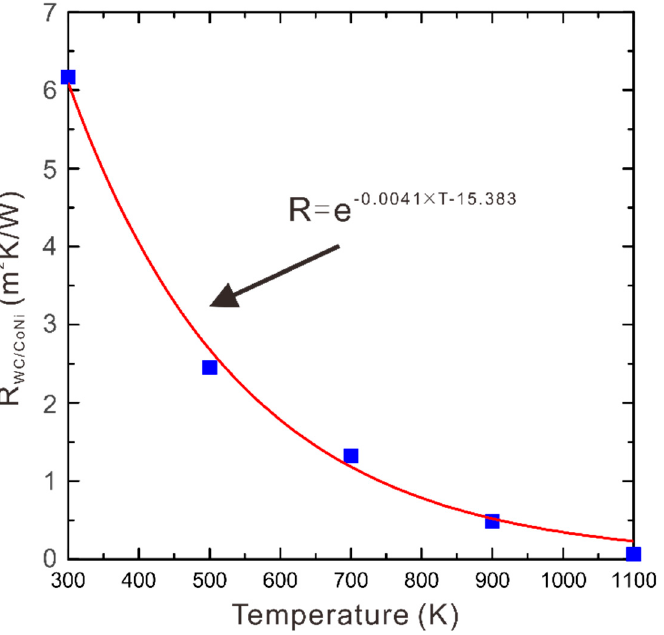
Figure 7. The calculated ITR in WC/(Co, Ni) interface along with the